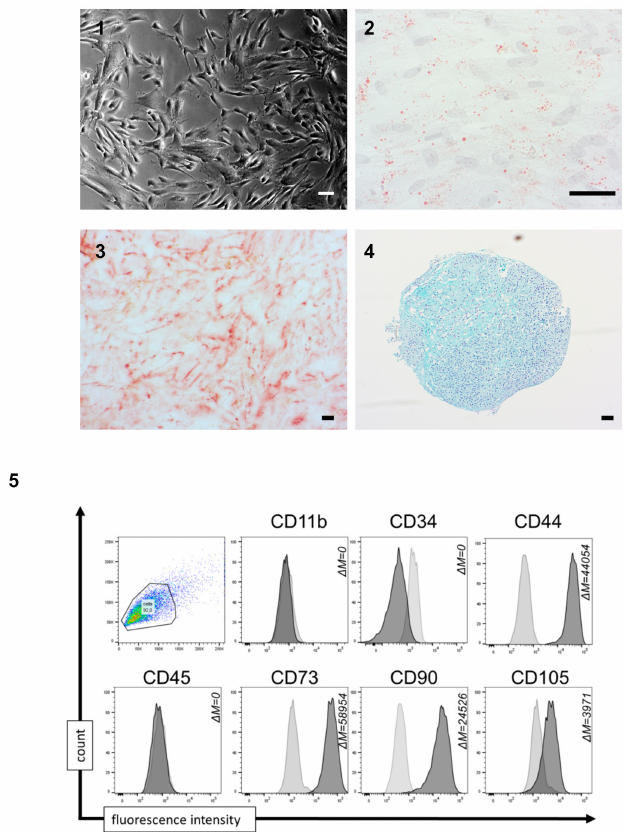
Figure 4. Characterization of induced pluripotent stem cell-derived mesenchymal stem cells (iP- MSCs). ( 1 ) Representative images from differentiated iP-MSCs in passage 3 (iP-MSC 3; scale bar 100 µ m). ( 2 – 4 ) Representative images of immunohistochemistry staining of iP-MSCs showing suc- cessful differentiation into adipocytes, osteocytes, and chondrocytes. ( 2 ) Adipogenic differentiation is detected with Oil Red O staining. ( 3 ) Osteogenic differentiation is detected with Alizarin Red, and ( 4 ) chondrogenic differentiation is detected with Alcian Blue (scale bars 100 µ m). ( 5 ) Representative diagrams of flow cytometric analyses of iP-MSCs at passage 3 (n = 4) for cell surface markers being expressed (CD44, CD73, CD90, and CD105) and cell surface markers being absent (CD11b, CD34, and CD45). Data are shown as an overlay histogram with the isotype control (light gray) and cell surface marker staining (dark gray) ( ∆ M = mean fluorescence intensity, MFI; difference between MFI measure and isotype